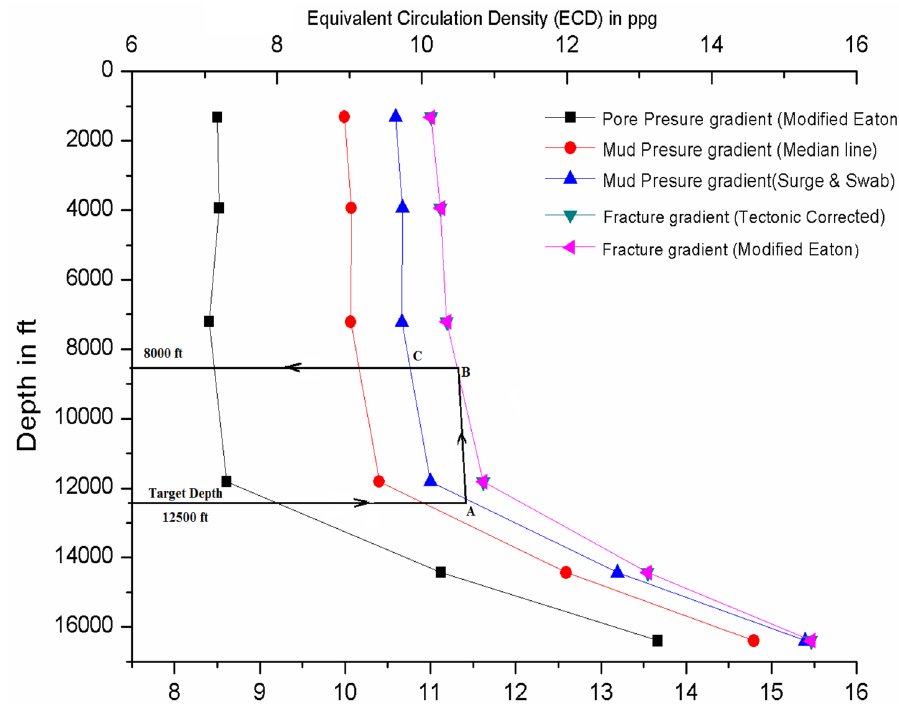
Fig. 10 Casing seat selection on the top of Atharamura